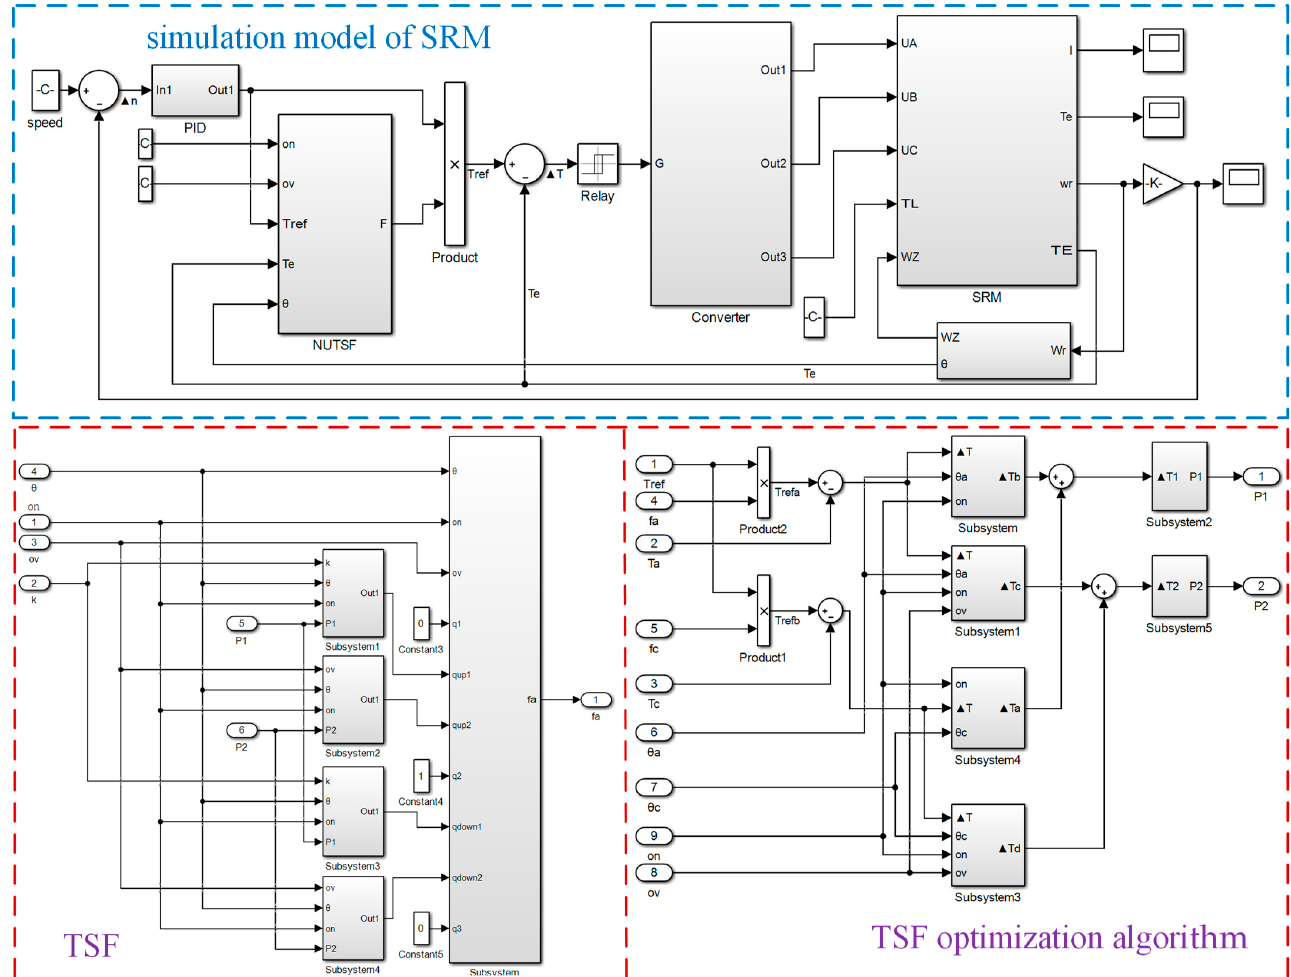
Figure 11. simulation model of SRM and one-phase NUTSF simulation model. Figure 11. Simulation model of SRM and one-phase NUTSF simulation Table 2. 6/20 SRM parameters.